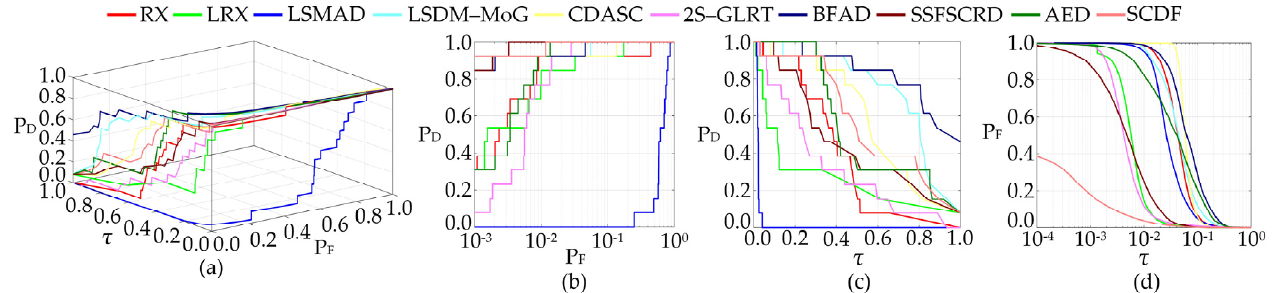
ROC curve (P D , τ ); ( d ) corresponding 2D ROC curve (P F , τ ).